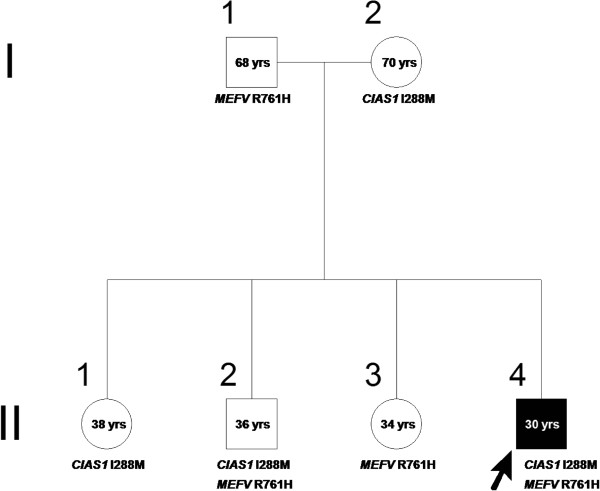
Absence of co-segregation of the mutations I288M inNLRP3(CIAS1) and R761H inMEFVwith the disease phenotype in the patient’s family members.